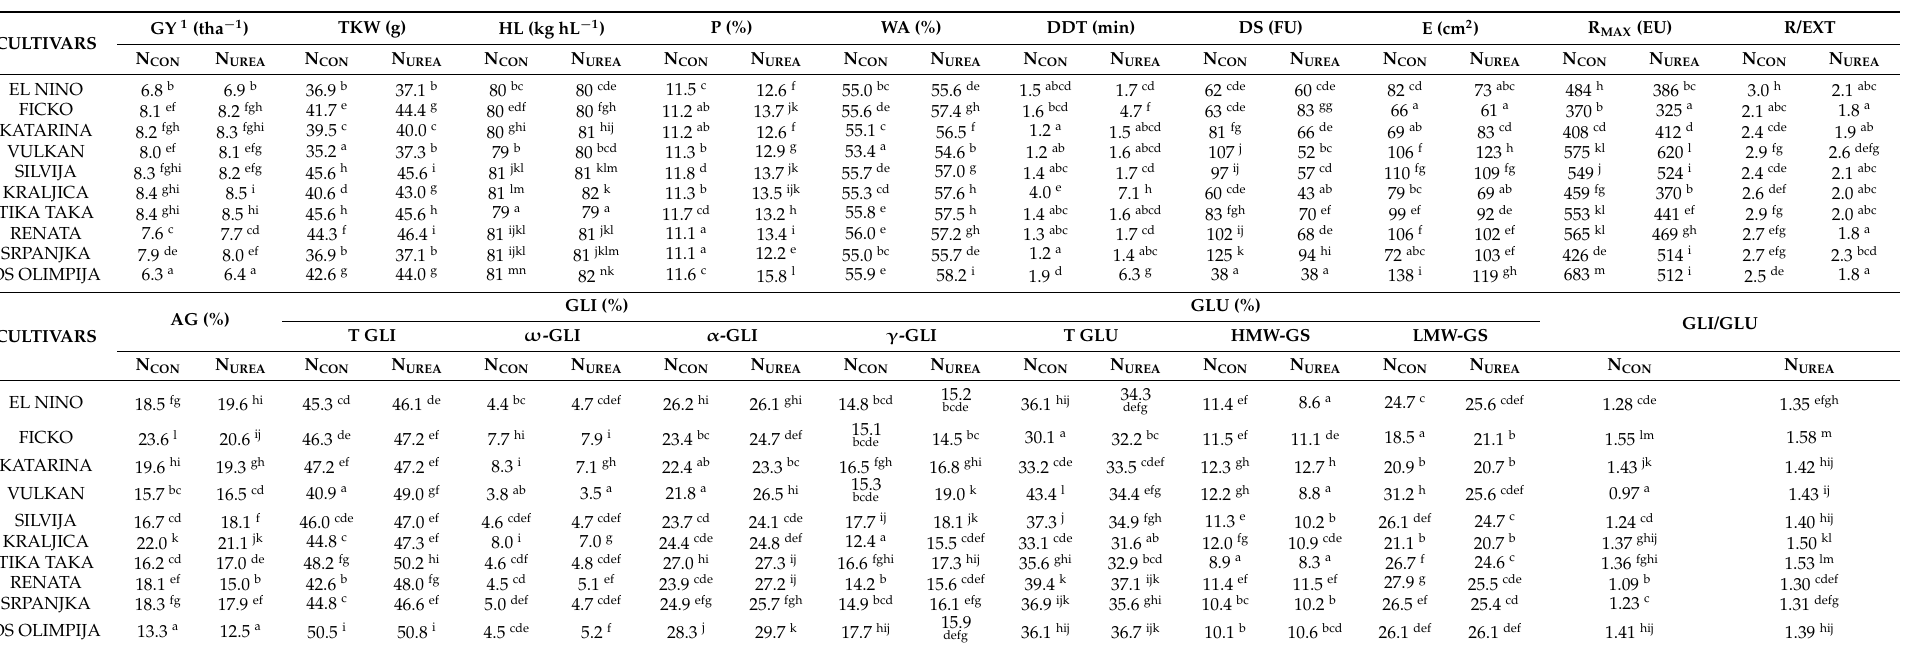
Table 6. Effect of the genotype x nitrogen interaction on agronomic and bread-making quality traits and protein components in wheat cultivars (means over